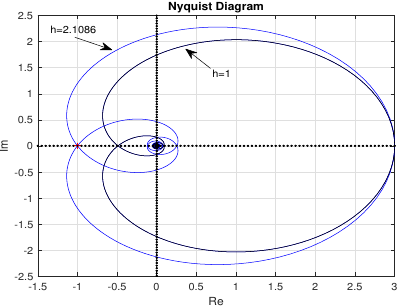
Figure 8. Nyquist diagram of the first order approximation for h = 1 and the critical point h = 2 . 1086.